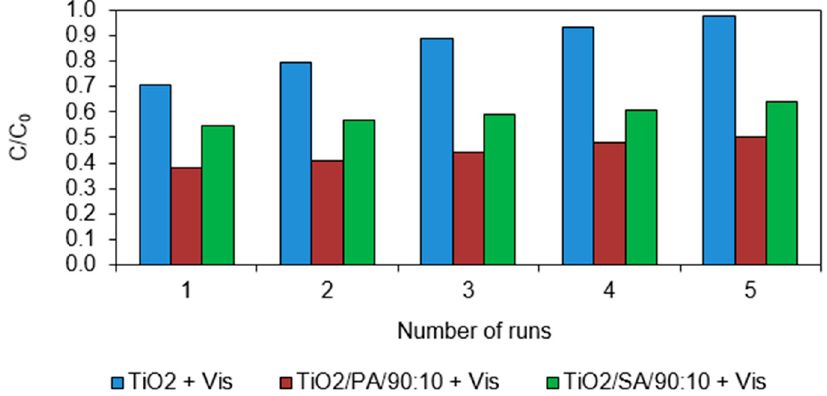
Figure 9. Effect of the number of cycles on the CFVP decomposition on the tested catalysts. Conditions of experiment: C 0 = 1.0 mg/L; D c = 50.0 mg/L; V r = 500.0 mL; t sor = 20.0 min; t ir = 60.0 min.